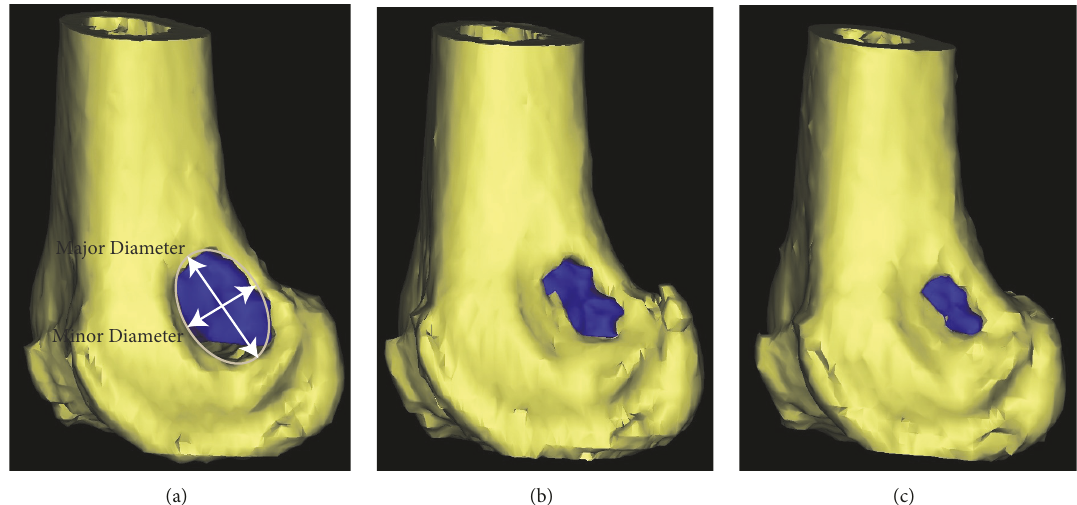
Figure 2: A 3D reconstruction of the example shown in Figure 1 at 1 year (a), 2 years, (b) and 3 years (c) postoperatively. The TCP is shown in dark blue. The new bone formation is not shown for clarity. The major and minor diameter of the cortical defect are shown (a).